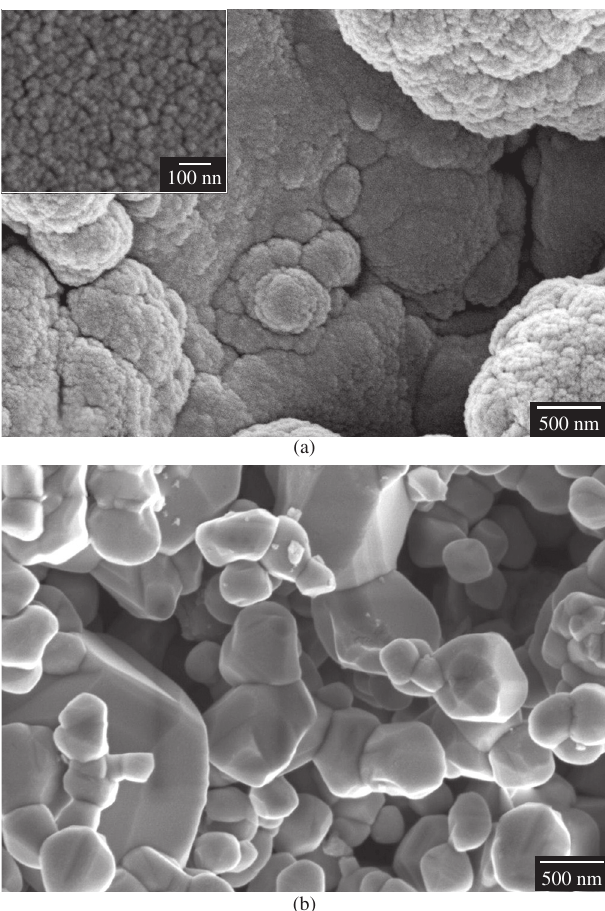
Figure 3. FE-SEM images of the films deposited by: a) sputtering and b) doctor-blade techniques. The inset shows a higher magnification where the small sputtered grains can be observed.